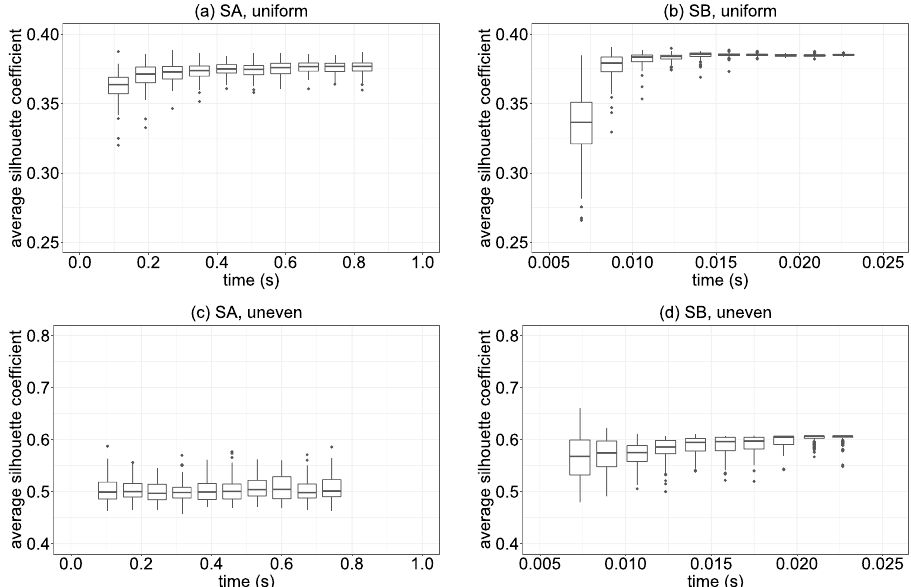
Figure 3. Box plots of the average silhouette coefficient for ( a , b ) the uniformly distributed data set and ( c , d ) the unevenly distributed one. ( a , c ) were obtained using SA, whereas ( b , d ) were obtained using SB. The horizontal axis is execution time.